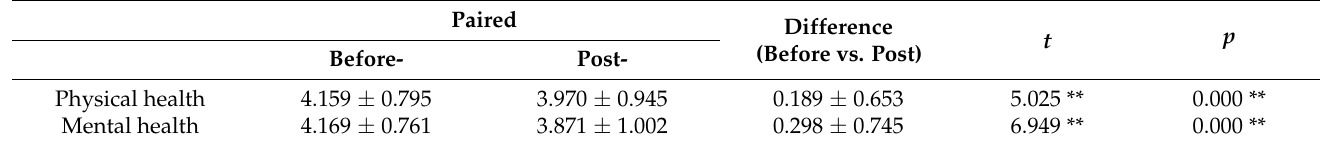
Table 4. Paired sample t -test results of physical and mental health before and after the pandemic. Paired Difference t p (Before vs. Post) Before- Post-